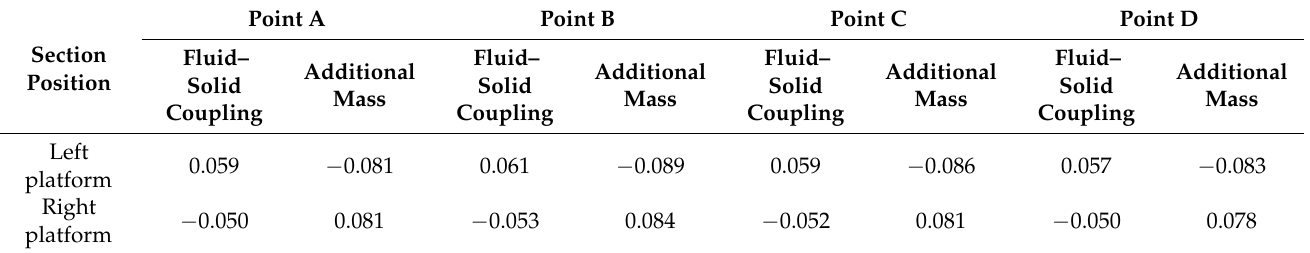
Table 2. Peak displacement response of the pipeline cross-section at the platform (unit: m).